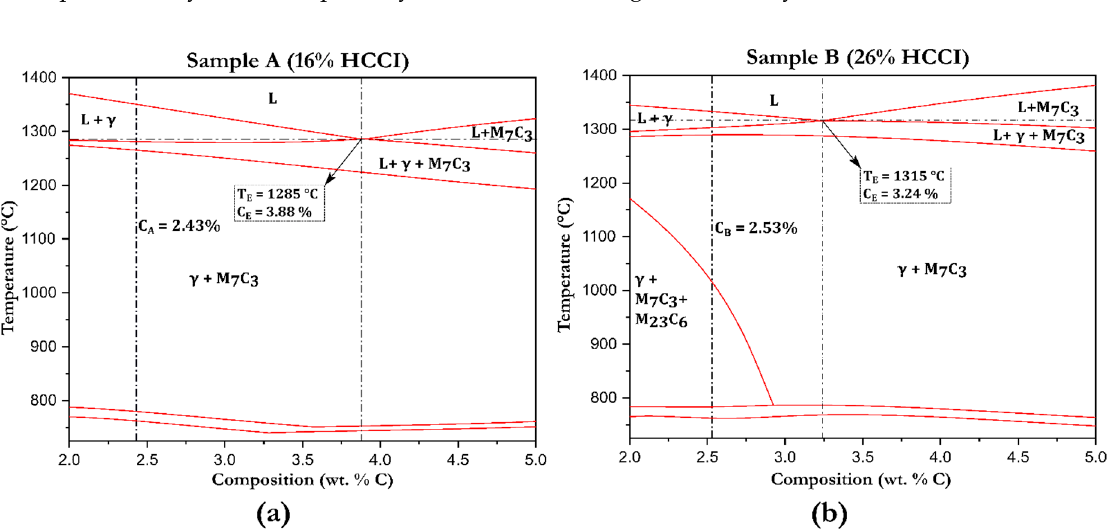
Figure 4. Pseudo-binary phase diagrams for samples, A and B computed using MatCalc 6. The eutectic transition temperature (T E ) and the corresponding eutectic carbon content (C E ) is indicated in the graphs along with the overall carbon content of ( a ) Sample A (C A ) and ( b ) Sample B (C B ).